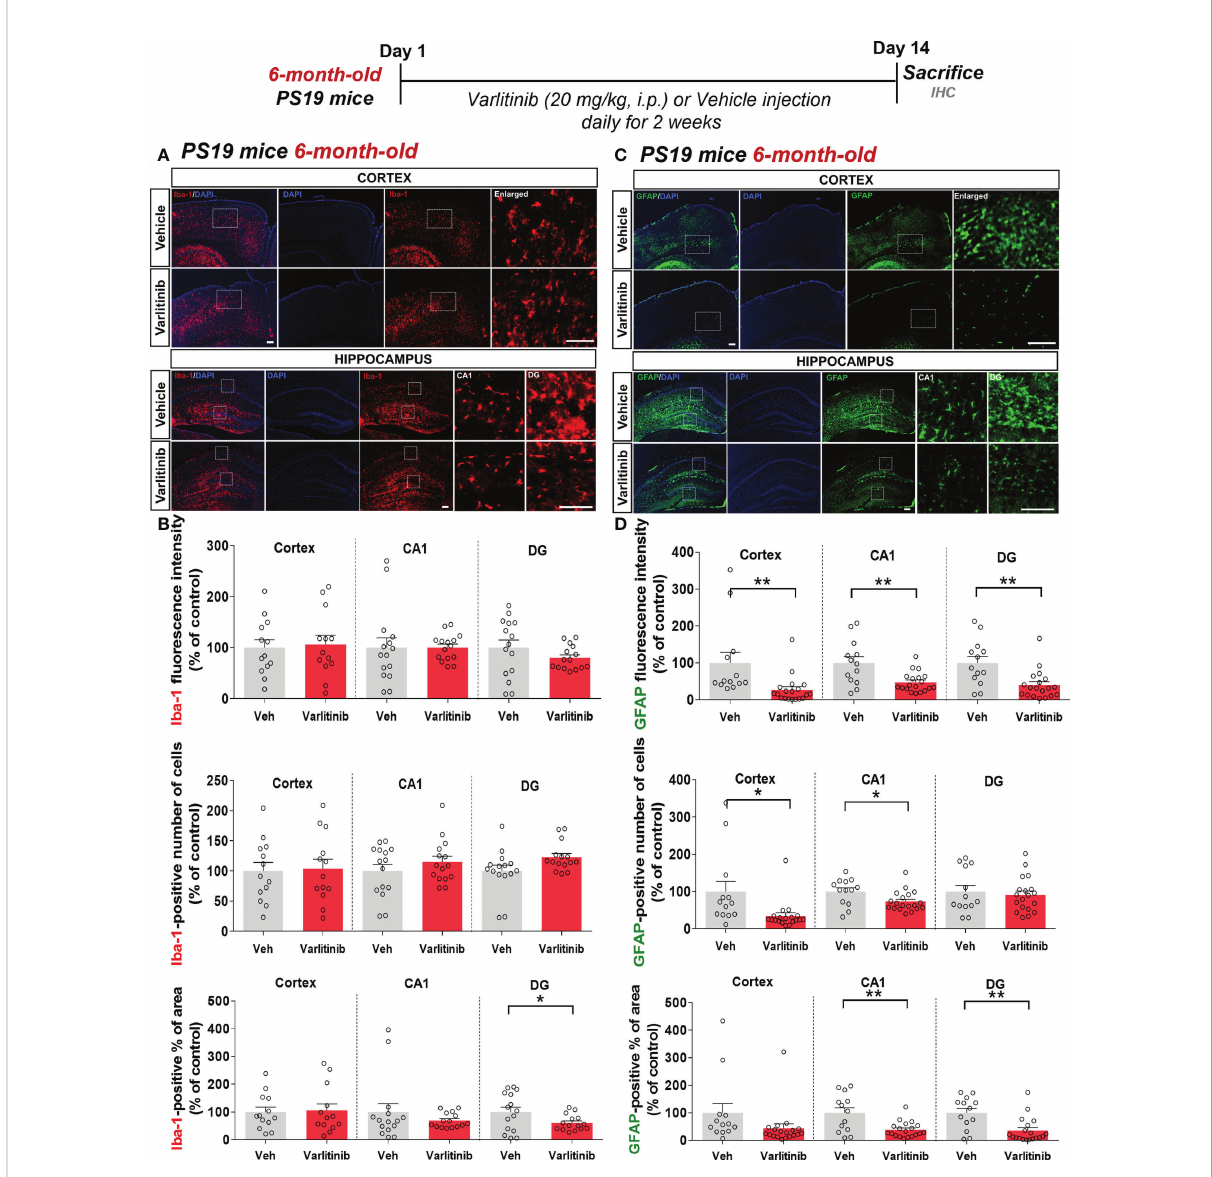
FIGURE 10 Varlitinib downregulates astroglial activation in 6-month-old tau-overexpressing PS19 mice. (A, C) Six-month-old tau-overexpressing PS19 mice were injected with varlitinib (20 mg/kg, i.p.) or vehicle (5% DMSO, 10% PEG, 20% Tween-80, i.p.) daily for 14 days, and immuno fl uorescence staining was conducted with anti-Iba-1 and anti-GFAP antibodies. (B, D) Quanti fi cation of data from (A, C) (n = 5 mice/group, Iba-1: Veh: 15 brain sections, Varlitinib: 15 brain sections; GFAP: Veh, 15 brain sections, Varlitinib: 15 brain sections). * p < 0.05, ** p < 0.01. Veh: Vehicle. Scale bar=50 m